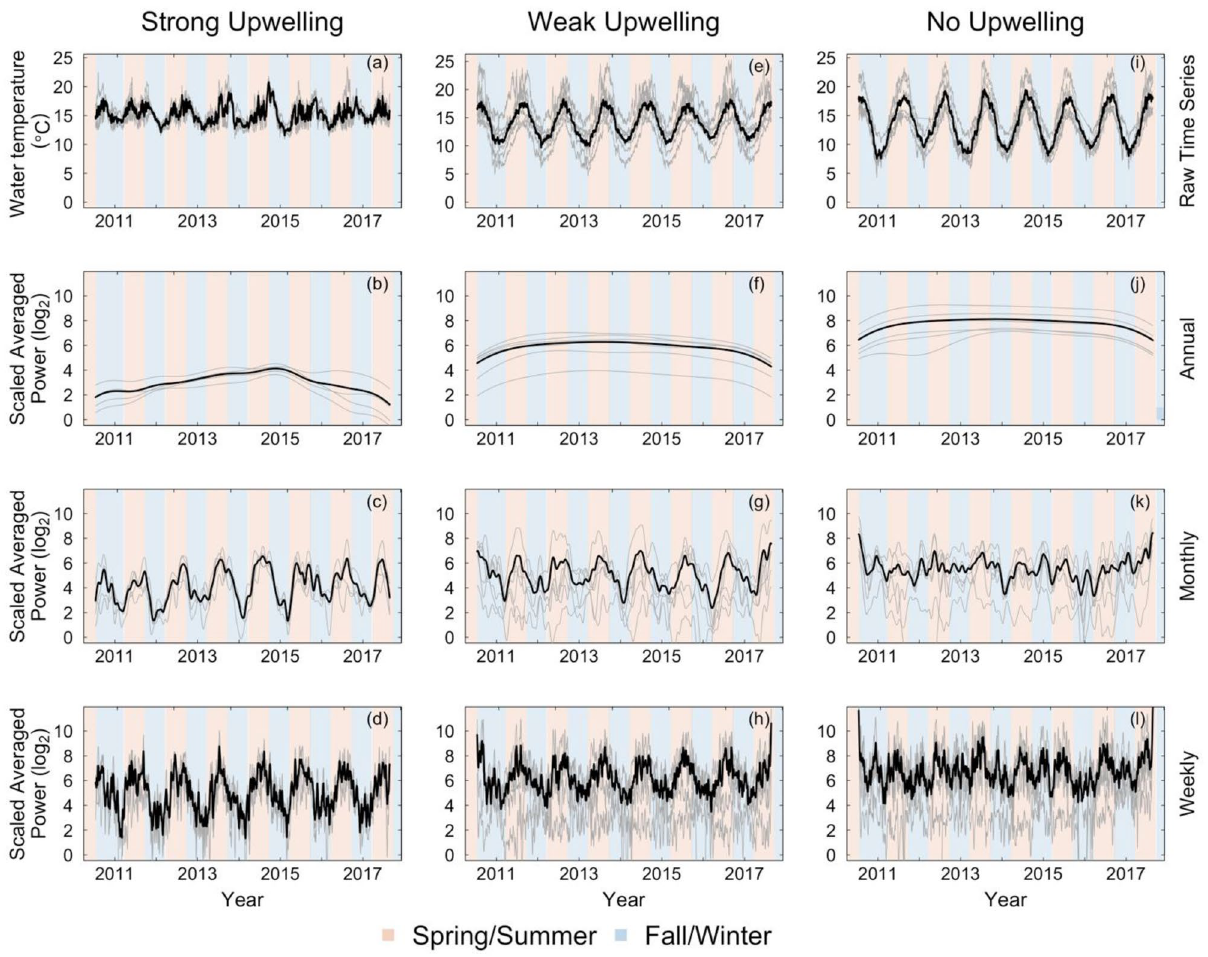
Figure 3. Time series and scale-averaged wavelet power for daily onshore water temperature at all sites. Columns represent site groupings based on upwelling strength (i.e., strong upwelling: 1.1–3.0, weak upwelling: 0.5–1.0, no upwelling: 0.0–0.4). The first row depicts the raw time series, and subsequent rows represent scale-averaged power at annual (300–400 days), monthly (15–45 days) and weekly (2–10 days) periodicities, respectively. Time series for individual sites are represented by grey lines and bold black lines depict the mean time series averaged across all sites. The background color indicates Spring/Summer months (orange) or Fall/ Winter months (blue).